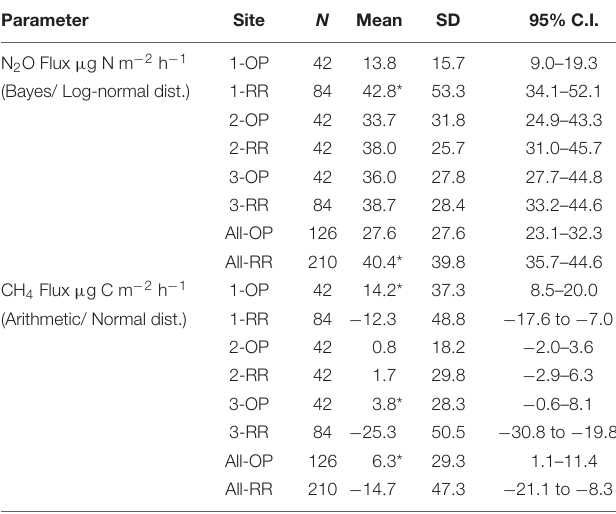
Frontiers in Forests and Global Change |